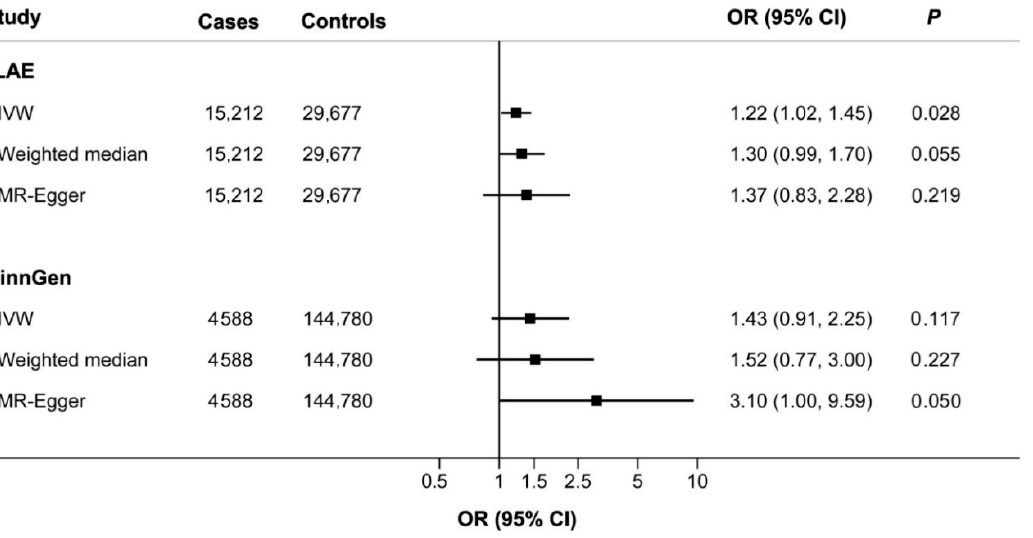
Figure 1. Associations of genetically predicted alcohol intake with epilepsy in the International League Against Epilepsy (ILAE) and FinnGen consortiums.